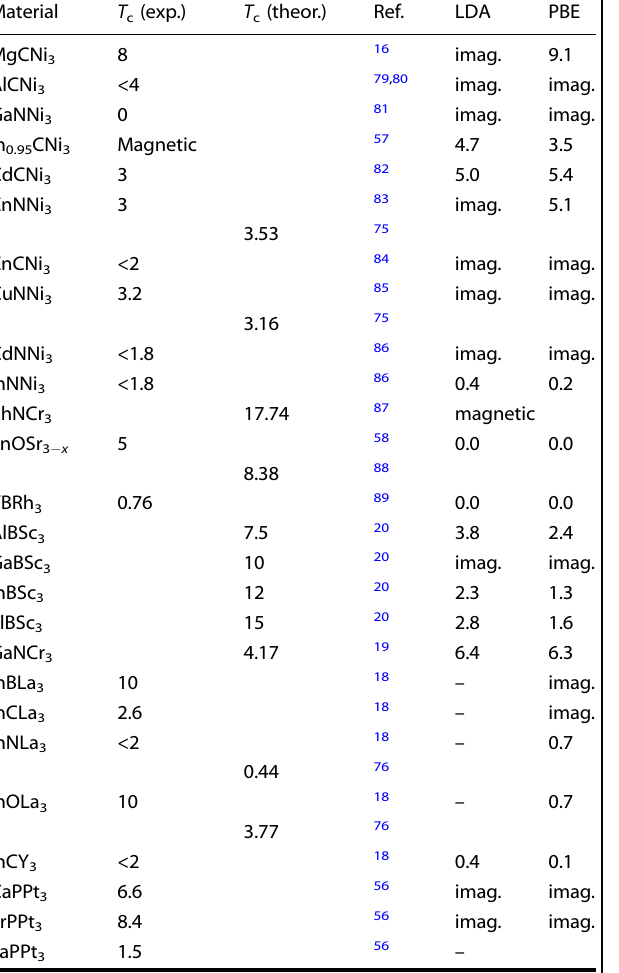
Table 1. Superconducting transition temperatures present in the literature in inverted perovskite systems compared to our results using the LDA and the PBE functionals. Material T c (exp.) T c (theor.)